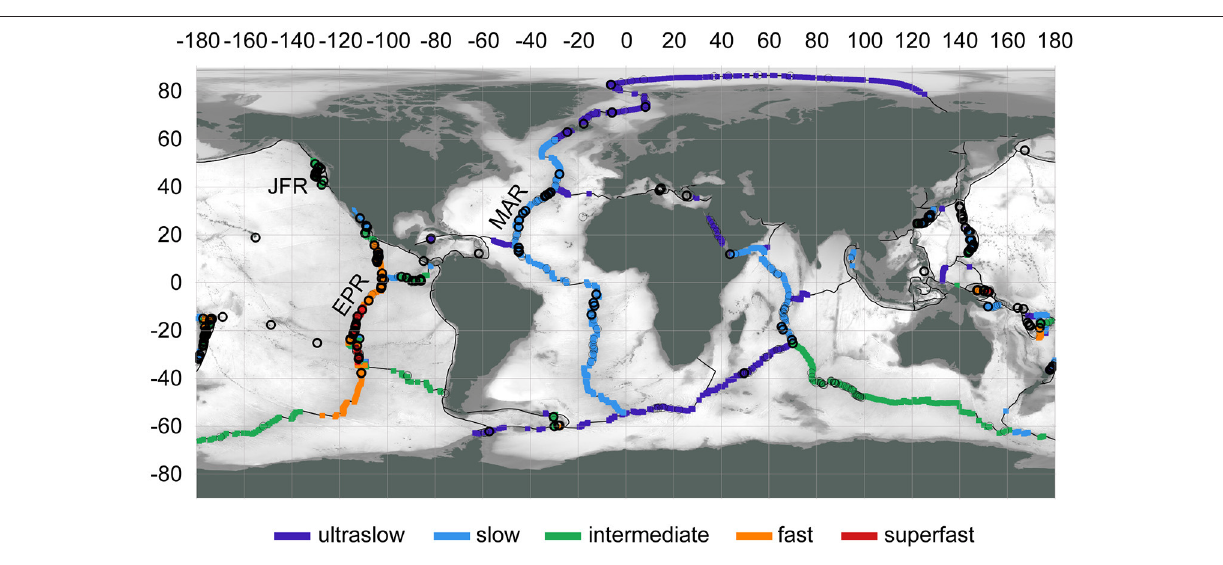
FIGURE 2 | Locations of active hydrothermal vent fields (circles), confirmed (thick outline) or inferred (thin outline), at water depths > 200m. Spreading rates categorized to: ultraslow ( < 20 mm/yr), slow (20–50 mm/yr), intermediate (50–80 mm/yr), fast (80–140 mm/yr), superfast ( > 140 mm/yr). Region labels: EPR, East Pacific Rise; JFR, Juan de Fuca Ridge; MAR, Mid-Atlantic Ridge. Map data: InterRidge Vents Database Version 3.3 (Beaulieu, 2015), PB2002 plate boundaries (Bird, 2003), ETOPO1 bathymetry (Amante and Eakins, 2009). Map produced with QGIS 2.18 (QGIS DevelopmentTeam,